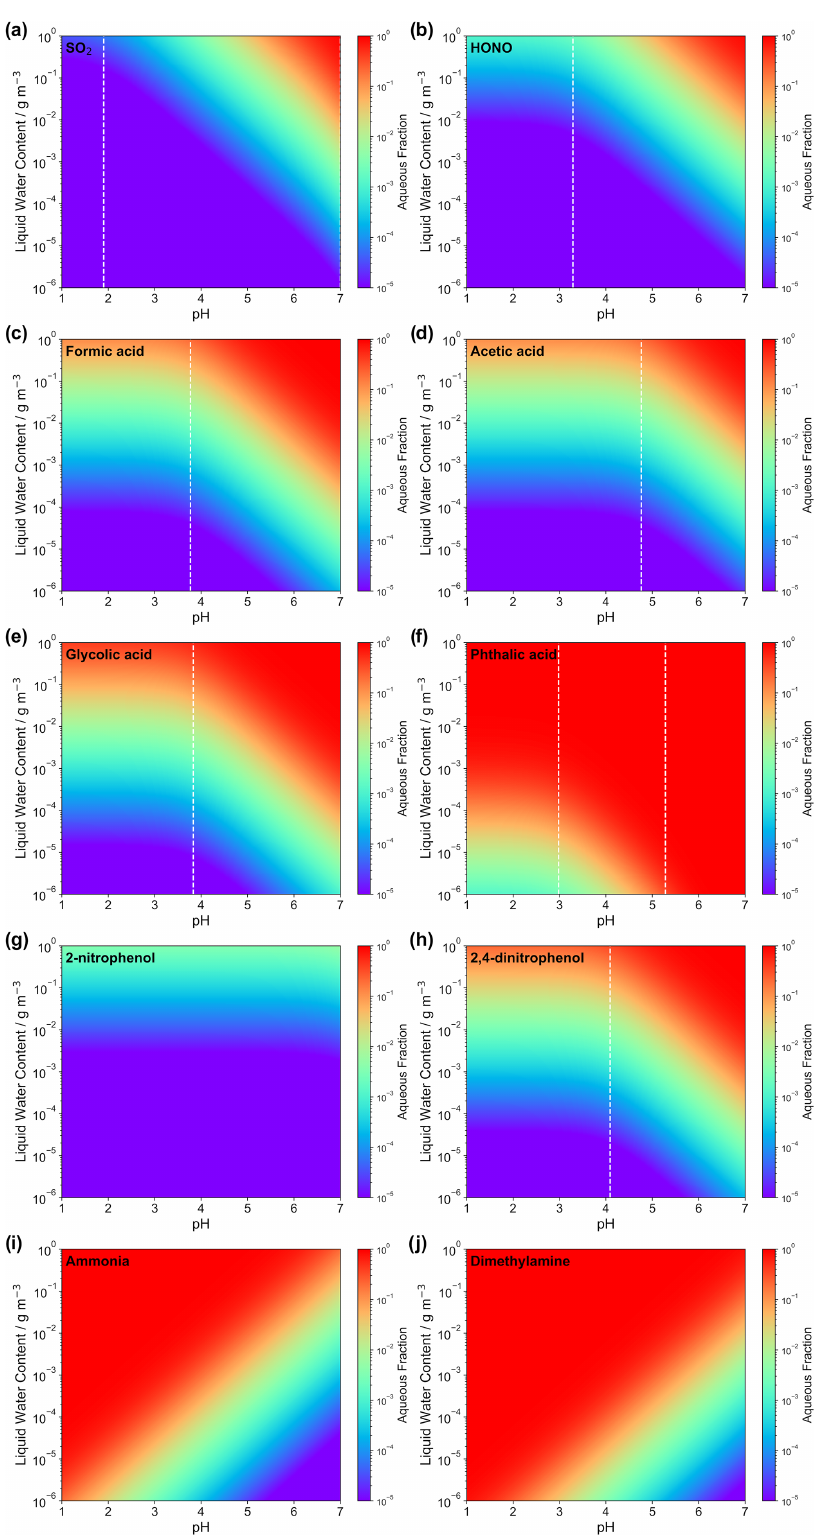
Figure 2. Calculated aqueous-phase fraction X A of eight selected weak acids (i.e., a SO 2 , b HONO, c formic acid, d acetic acid, e gly- aq colic acid, f phthalic acid, g 2-nitrophenol, and h 2,4-dinitrophenol) and bases (i.e., i : ammonia and j : dimethylamine) as a function of the LWC and acidity. The black lines are the isolines of the aqueous fractions of 10 − i ( i = 1, ... , 6). The dashed white lines indicate pK a values of the corresponding acids (except for the two bases and for 2-nitrophenol due to the very high pK a of 7.2; see Table S1). https://doi.org/10.5194/acp-21-13483-2021 Atmos. Chem. Phys., 21, 13483–13536,